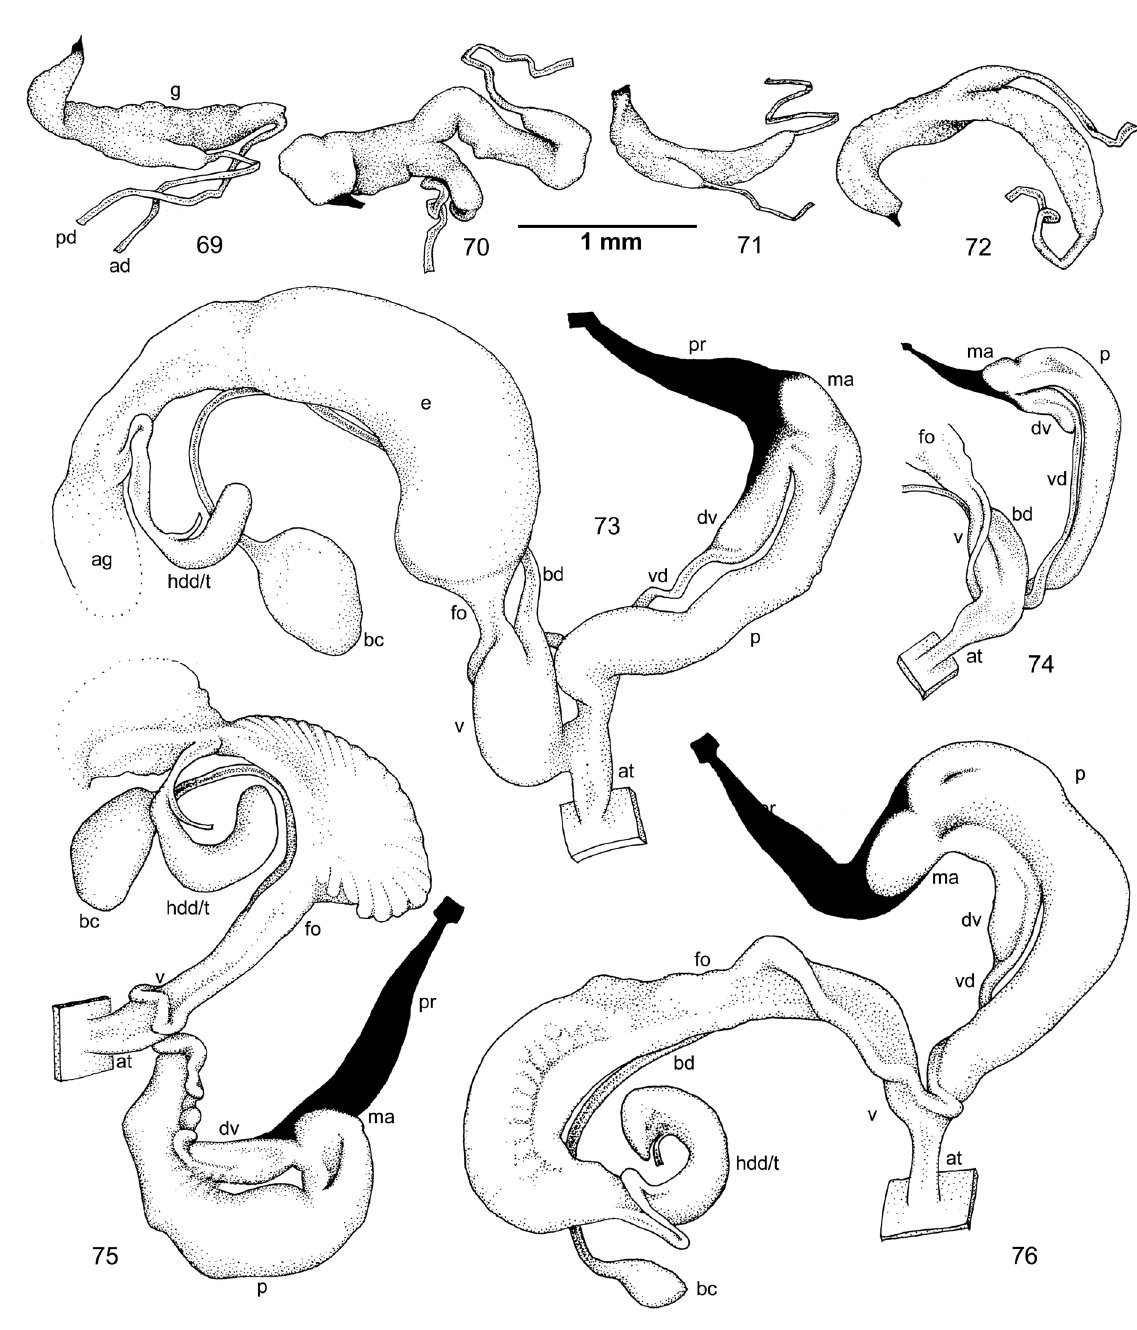
Figs 69-76. Salivary glands and genitalia of Dadagulella gen. nov. species. 69. D. radius radius , Amboni. 70. D. pembensis sp. nov., Ngezi. 71. D. browni browni , Kosi Bay. 72. D. delta sp. nov., Mwanihana. 73. D. radius radius , Amboni. 74. D. browni browni , Kosi Bay. 75. D. pembensis sp. nov., Ngezi. 76. D. delta sp. nov., Mwanihana. Abbreviations: ad = anterior duct of salivary gland; ag = albumen gland; at = atrium; bc = bursa copulatrix; bd = bursa duct; dv = diverticulum of vas deferens; e = egg; fo = free oviduct; hdd/t = hermaphroditic duct diverticulum / talon; ma = muscular apex; p = penis; pd = posterior duct of salivary gland; pr = penial retractor muscle; v = vagina; vd = vas